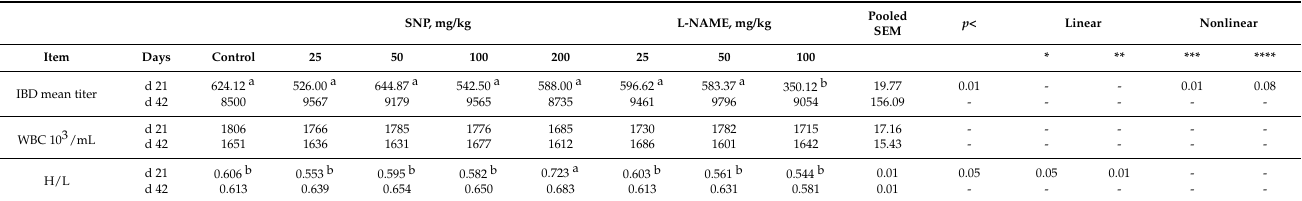
Table 4. Effect of dietary sodium nitroprusside (SNP) and N G -nitro-L-arginine methyl ester (L-NAME) supplementation on some immune response